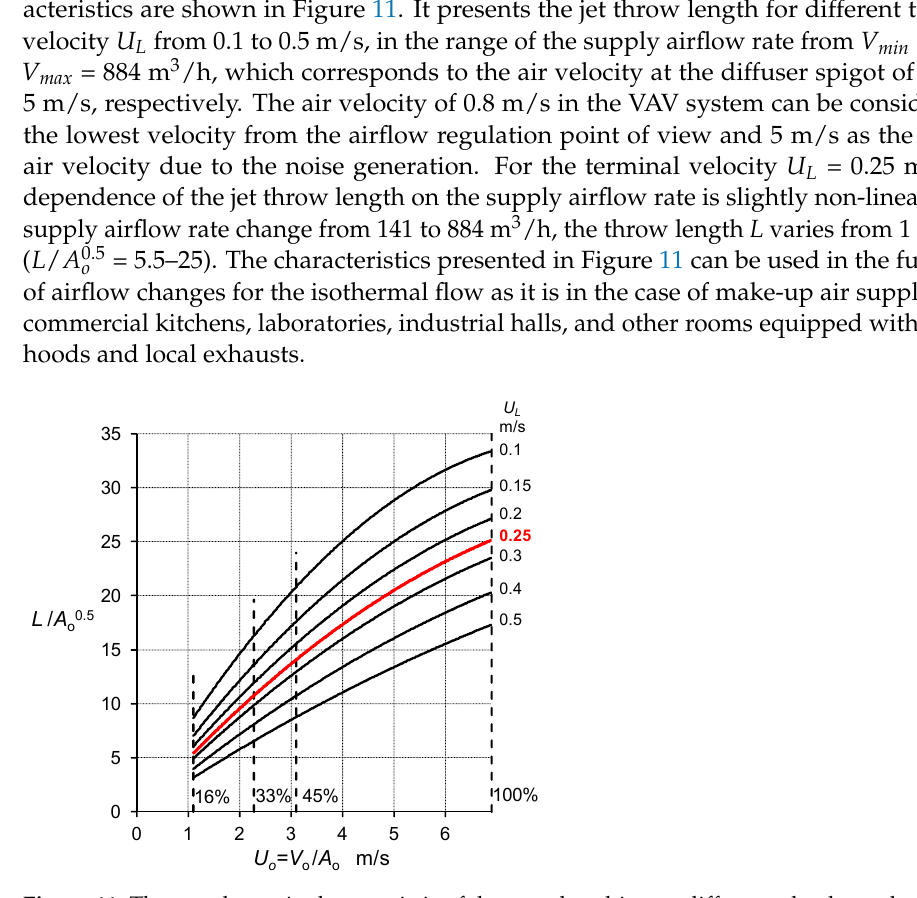
Figure 11. The aerodynamic characteristic of the tested multi-cone diffuser—the dependence of the jet throw length on the supply airflow rate.